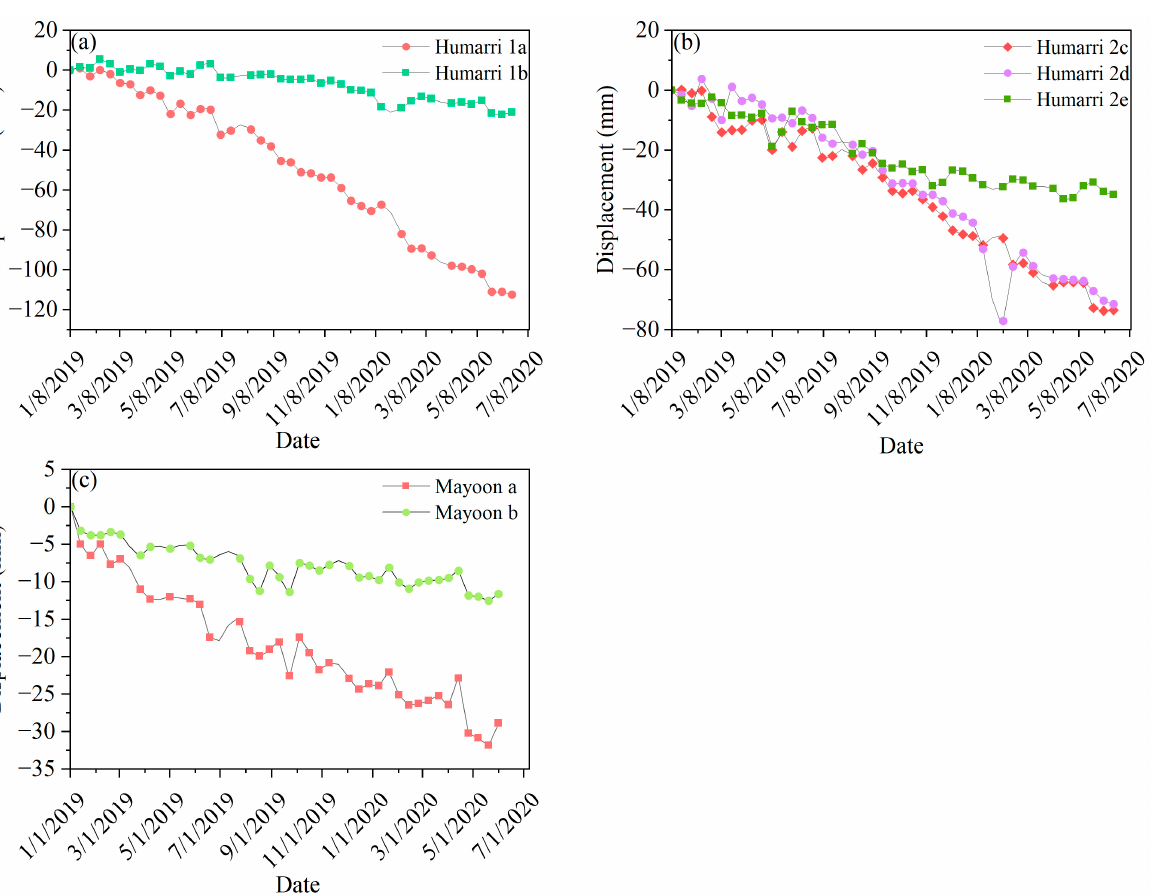
Figure 14. The deformation time series of large landslides. ( a ) Humarri-1; ( b ) Humarri-2; the analysis points a–e are identified in Figure 8c; ( c ) Mayoon; the analysis points a and b are identified in Figure 8f. Tectonically, the Mayoon and Jizalabad landslides lie at the northern margin of the Kohistan Island Arc (KIA), bounded between the Main Karakoram Thrust (MKT) and the South Murtzabad Fault. The present investigation and the previous GPR tests declared that there are highly heterogeneous materials deposited in the top layers of Mayoon [5]. The head and body of the Mayoon landslide are covered by unconsolidated material and have fractures of varying lengths and widths (Figure 13d), and the fragmented and accumulated materials are obviously from the Jizalabad landslide (Figure 13e). The time series analysis revealed that the displacement histories of the Mayoon upper and lower parts are similar, but the upper part experienced larger accumulative deformations, three times greater than the lower body during the monitoring period (Figure